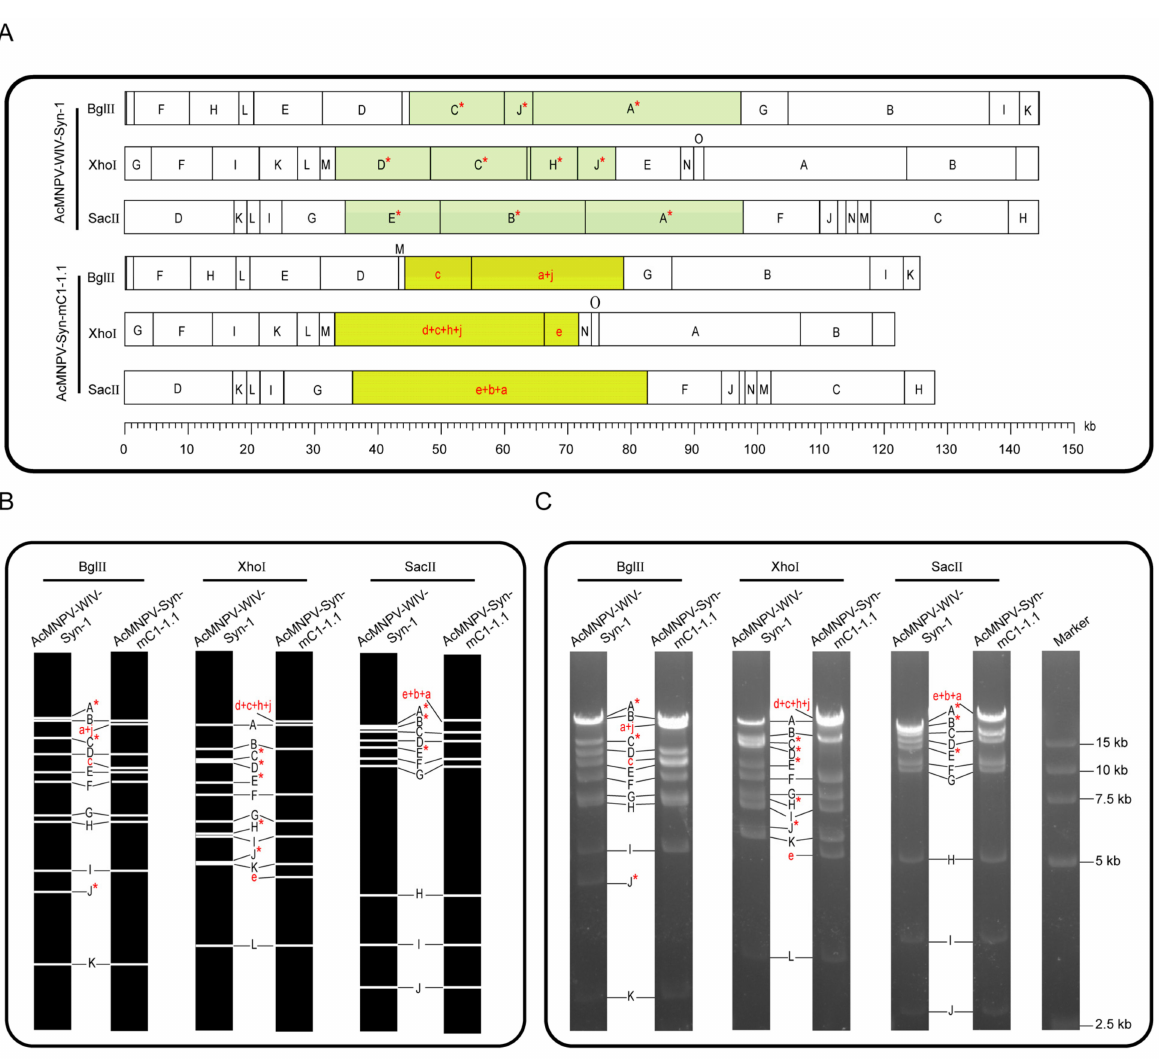
Figure 4. Restriction enzyme analyses of the genomes of AcMNPV-Syn-mC1-1.1 and AcMNPV –WIV- Syn1. ( A ) Physical maps of the AcMNPV-Syn-mC1-1.1 and AcMNPV-WIV-Syn1 genomes digested with BglII, XhoI or SacII. The fragments were named alphabetically according to size. The fragments corresponding to the C1 region in AcMNPV-WIV-Syn1 and the modified C1 region in AcMNPV-Syn- mC1-1.1 are highlighted. ( B ) Computer-simulated restriction enzyme profiles of AcMNPV-WIV-Syn1 and AcMNPV-Syn-mC1-1.1. ( C ) Electrophoresis results of the restriction enzyme-digested DNA samples of AcMNPV-WIV-Syn1 and AcMNPV-Syn-mC1-1.1 in 1% agarose gel. Fragments with size change are indicated in red letters in AcMNPV-Syn-mC1-1.1 and the original fragments in AcMNNPV-WIV-Syn1 are marked with a red